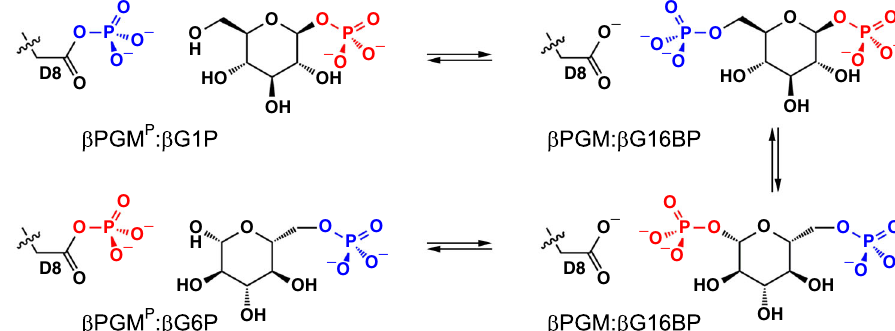
Fig. 1 β PGM catalytic cycle. β PGM reaction scheme for the enzymatic conversion of β G1P to G6P via a β G16BP intermediate. The phosphoryl transfer reaction between phospho-enzyme ( β PGM P , phosphorylated at residue D8) and β G1P is illustrated with the transferring phosphate (blue) in the proximal site and the 1-phosphate (red) of β G1P in the distal site. The phosphoryl transfer reaction between β PGM and β G16BP is shown with the transferring phosphate (red) in the proximal site and the 6-phosphate (blue) of β G16BP in the distal